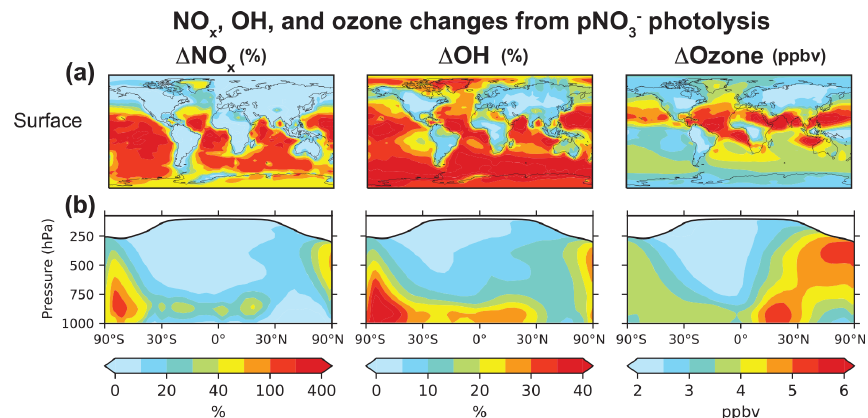
− photolysis in GEOS-Chem. Panel (a) 3 photolysis, and changes in ozone are shown as differences 3